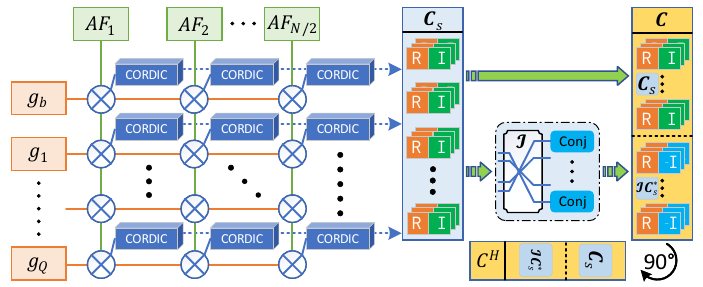
Figure 12. The block diagram of the constraint matrix